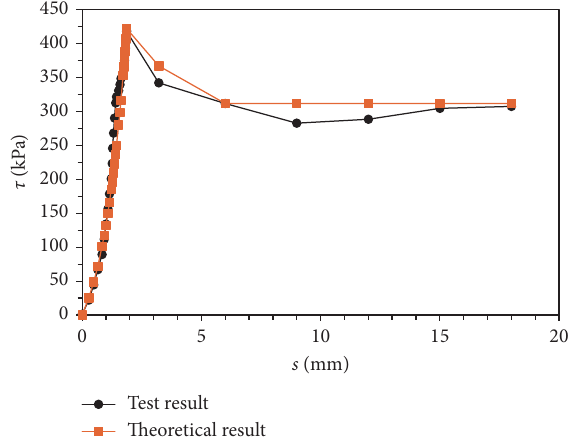
Figure 22: Comparison between test result and theoretical result of